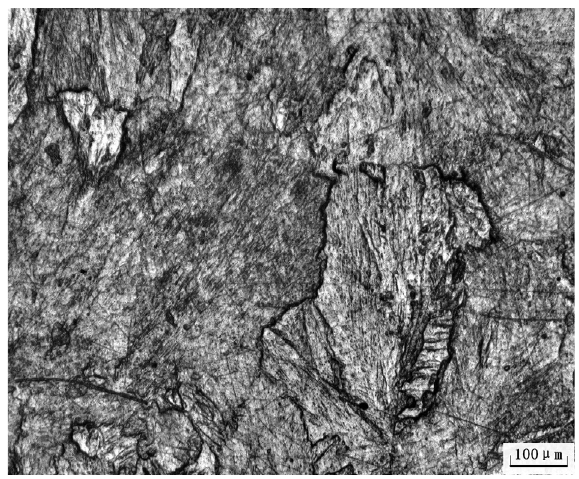
Figure 1: Microstructure of as-cast Ti-7Cu alloy.